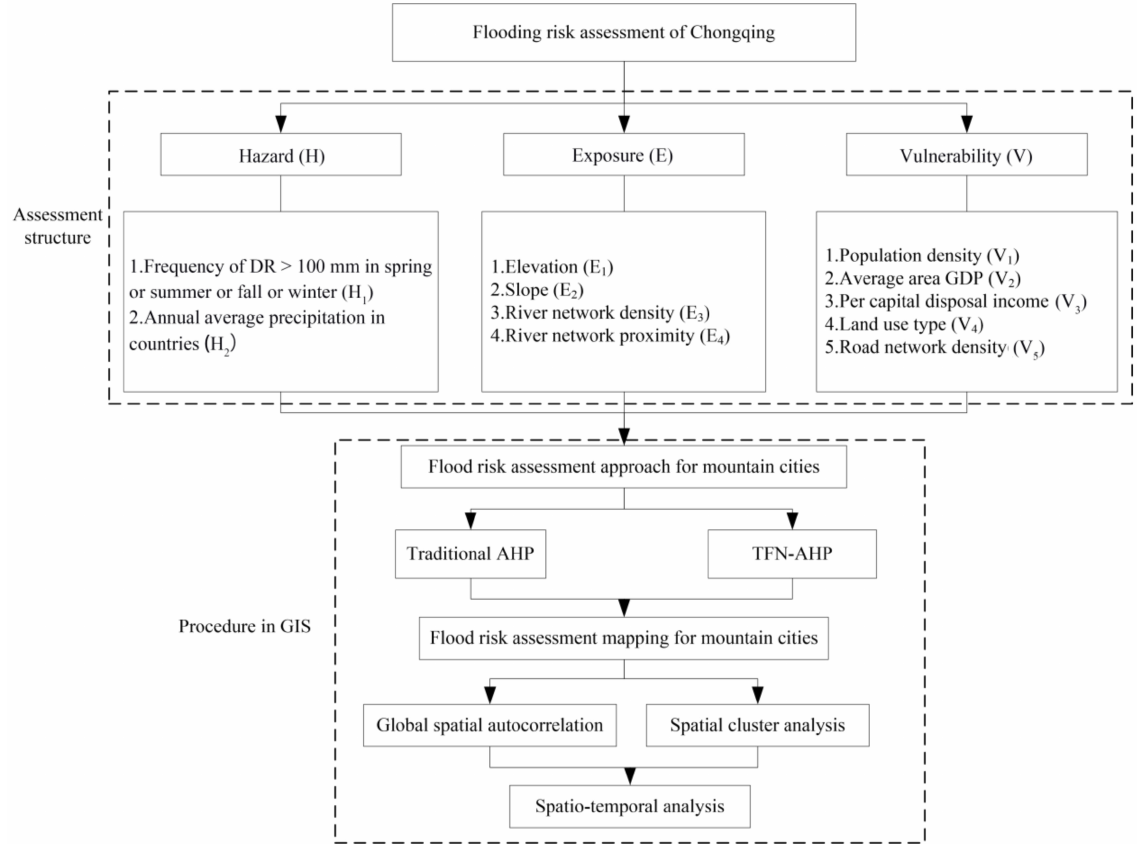
Figure 2. Flowchart of the flood risk assessment for Chongqing. Note: DR means the daily rainfall of counties and GDP is Gross Domestic Product of each county in